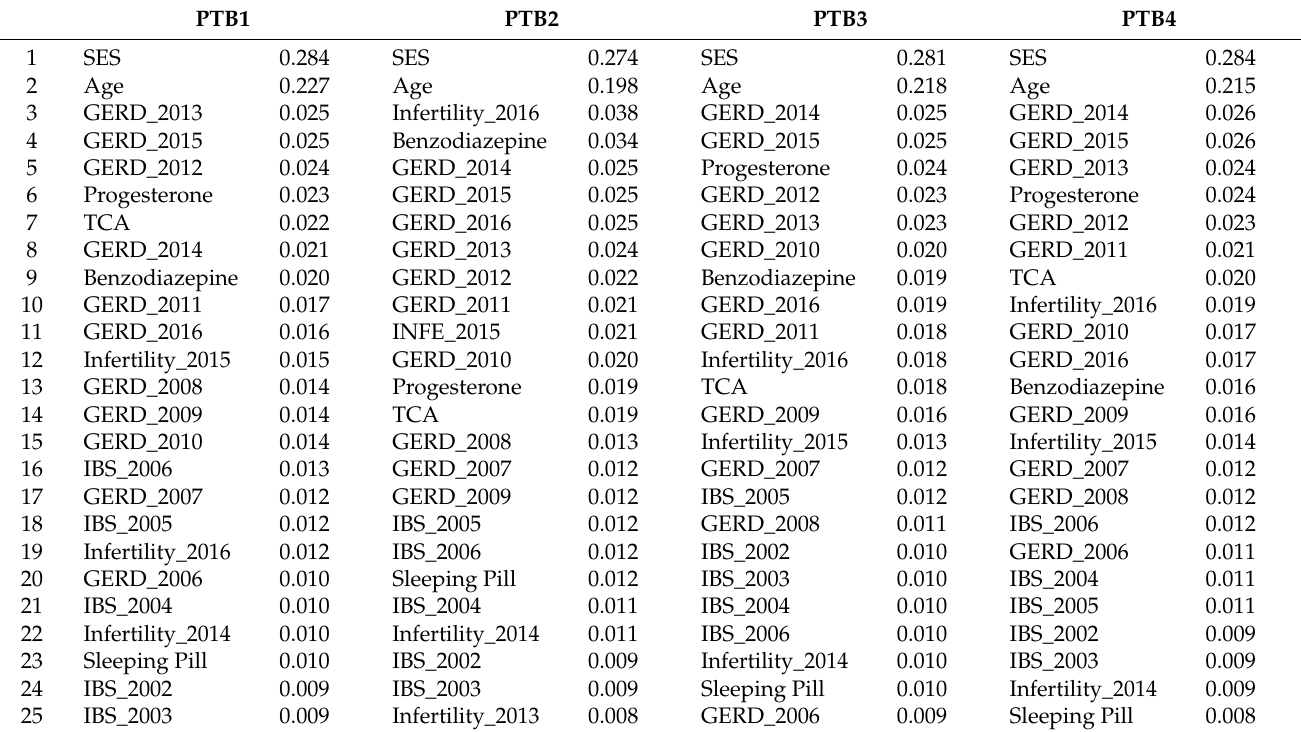
Table 2. Random forest variable